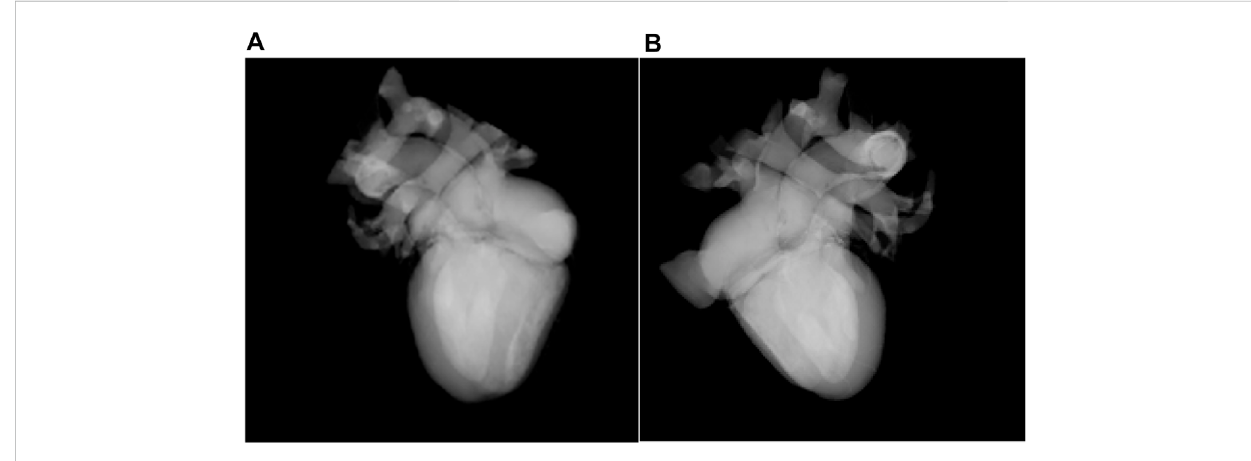
FIGURE 5 Rendering of the biological structure of the heart (A) . Rendering result from one viewpoint (B) . Rendering result from a different viewpoint.